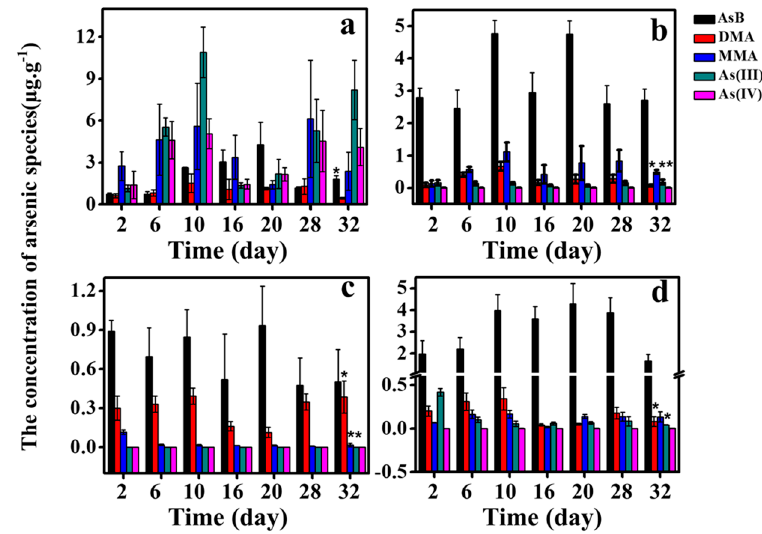
Figure 3. The concentrations of five As species (AsB, DMA, MMA, AS(III), and As(IV)) in: ( a ) intestine; ( b ) liver; ( c ) muscle; and ( d ) gill over 32 days of As(III) exposure. Analysis of variance was used to test differences of arsenic species during the experiment period and significance was marked on 32nd day ( p < 0.05).